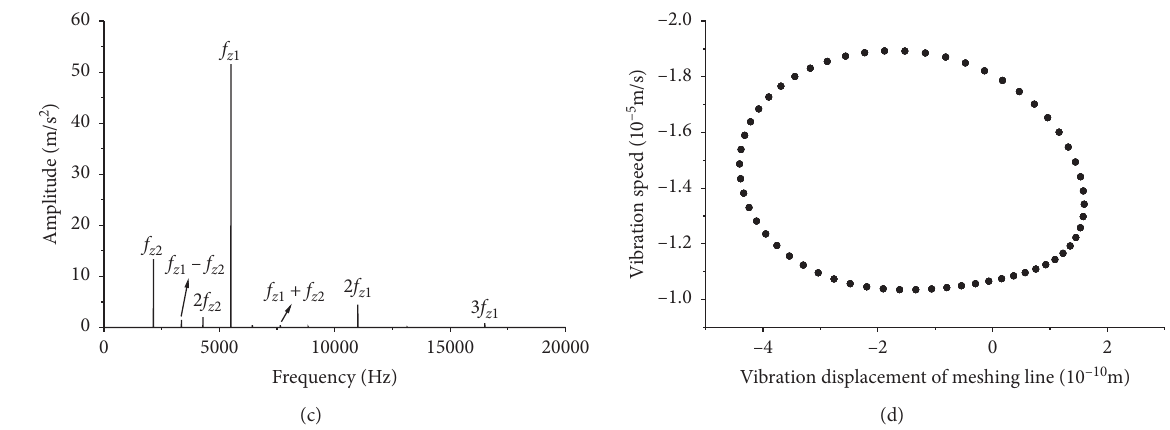
Figure 13: Vibration response of the input-stage gear pair of a two-stage helical gear transmission system at 15,000rpm: (a) time-domain diagram, (b) phase diagram, (c) frequency-domain diagram, and (d) Poincar´e section.